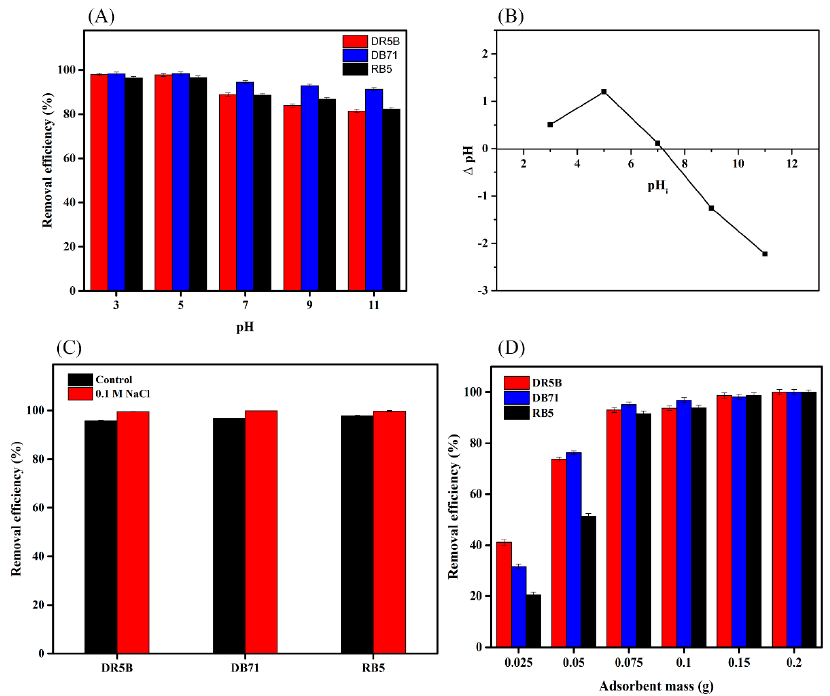
Figure 4. Effect of ( A ) pH; ( B ) the point of zero charge of SMWC; ( C ) ionic strength; and ( D ) adsorbent dosage on dye removal.